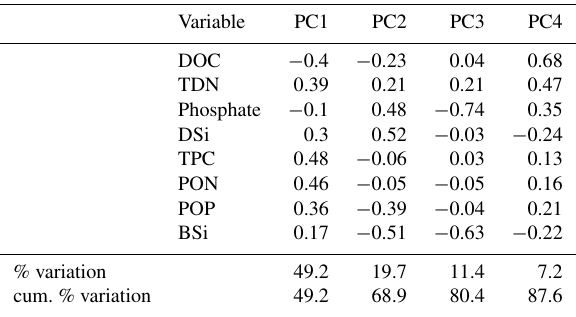
Table 2. Eigenvectors and explained variation of the first four axes of a PCA on normalized variables of dissolved and particulate nu- trients. Ordination of the PCA is visualized in Fig. 6.